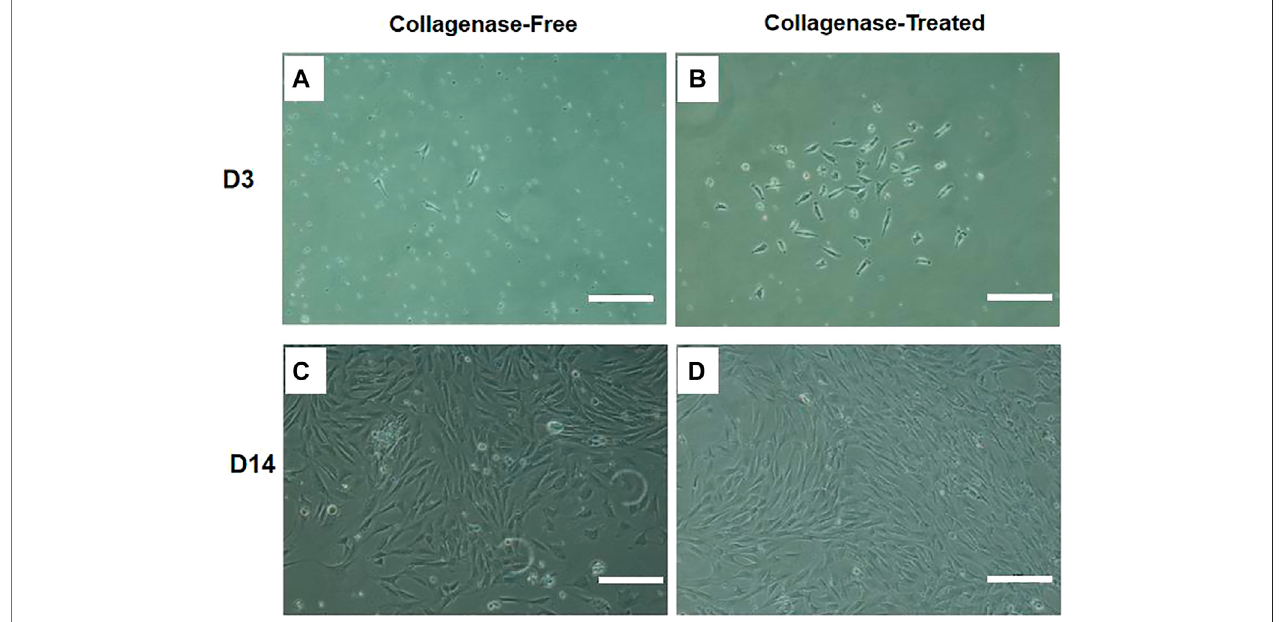
FIGURE 1 | Representative diagram of IPFP-SCs extraction by the without enzyme method and digestion method. Scale bar = 200 μ m.